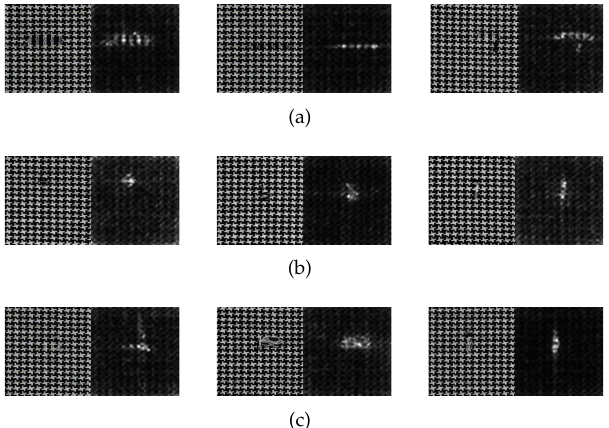
Figure 10. Saliency map of star-patterned fabric defect detection. ( a ) broken end type; ( b ) hole type; ( c ) netting multiple